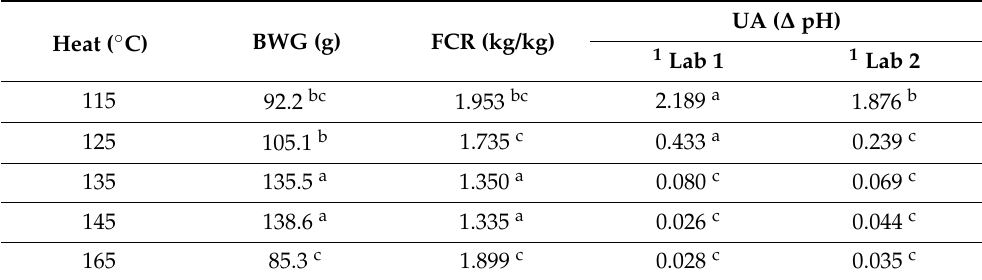
Table 4. Urease activity of FFSBM Processed at Different Temperatures and Laboratories on Body